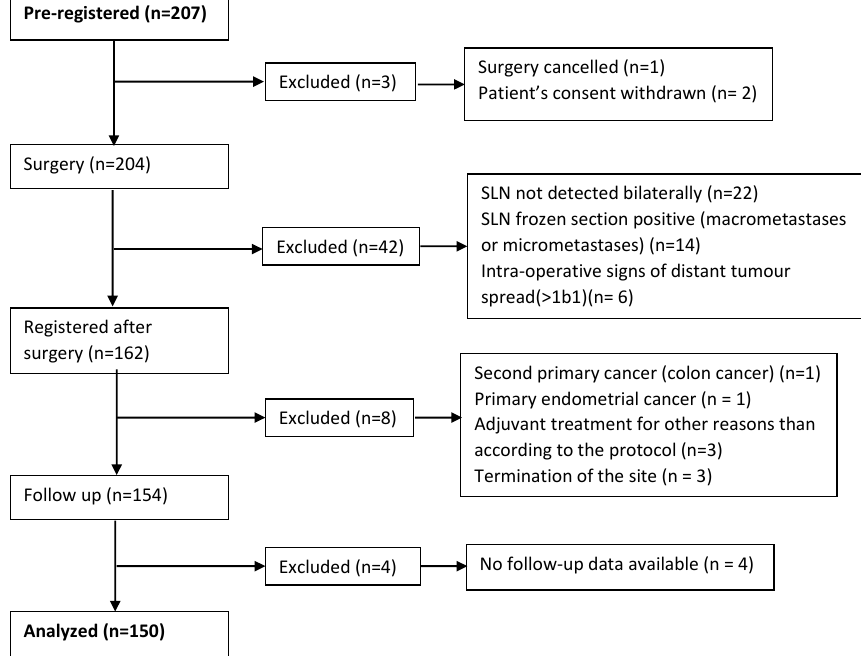
Figure 1. Flow chart of patients registered in the SENTIX trial.